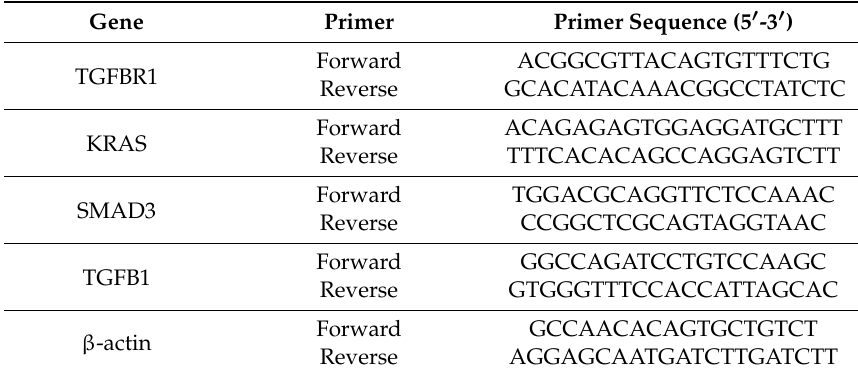
Table 2. Primer sequences of the genes used in